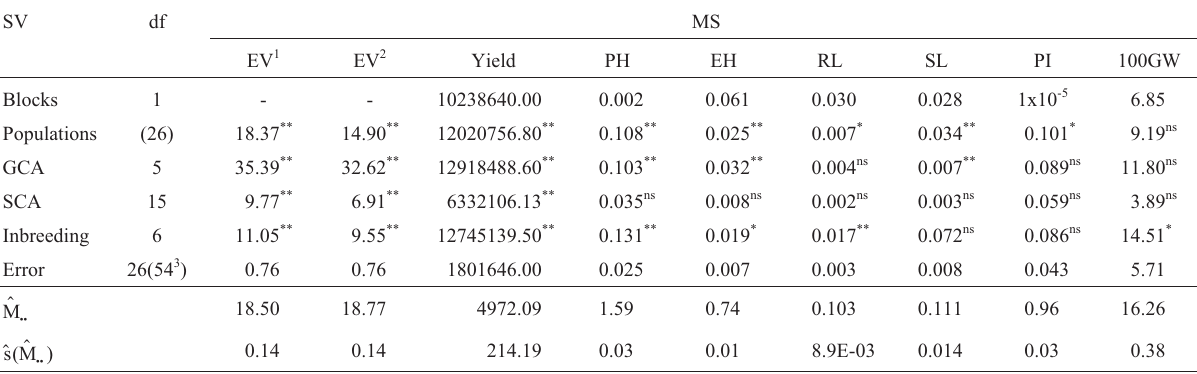
Table2 -Diallelanalysisofexpansionvolume(EV,mL/g),yield(kg/ha),plantheight(PH,m),earheight(EH,m),proportionofrootlodgedplants(RL), proportion of stalk lodged plants (SL), prolificacy index (PI), and one hundred grains weight (100GW, g), of six popcorn populations, their hybrids and selfed parents, and estimates of the diallel mean and its standard